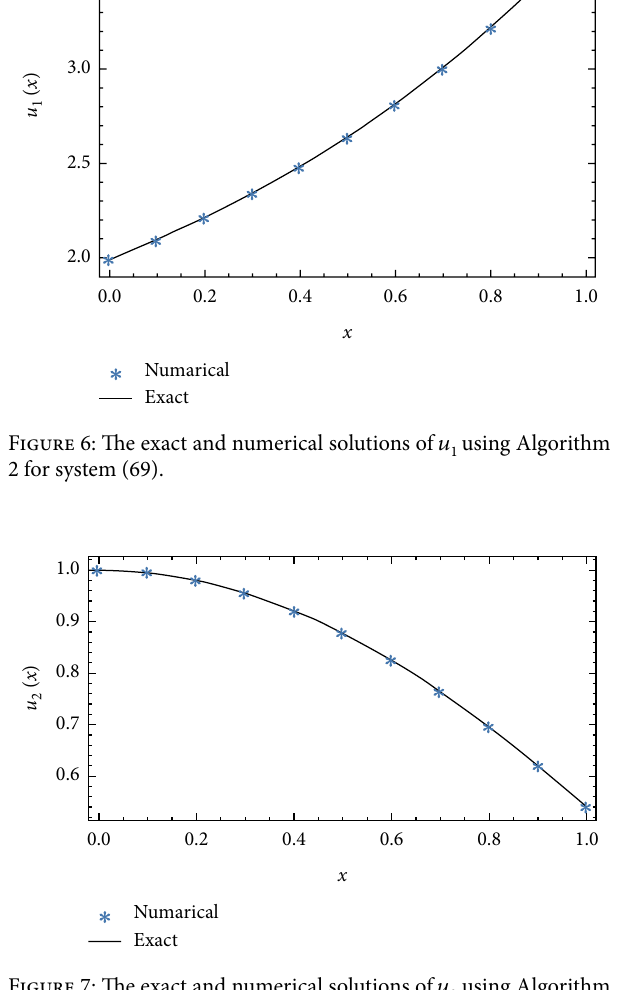
using Algorithm 𝑢 2